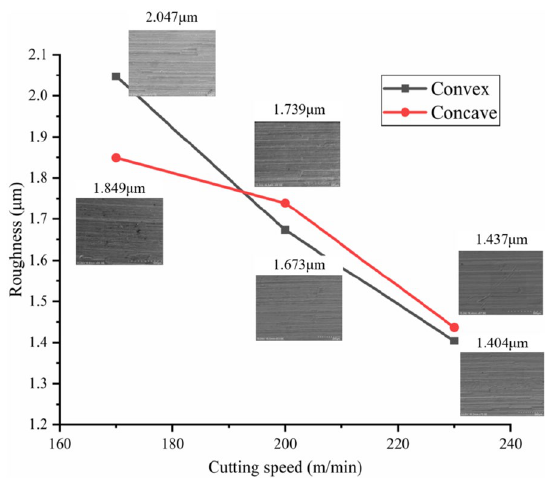
Figure 12 Effect of cutting speed on the morphology of machined concave and convex